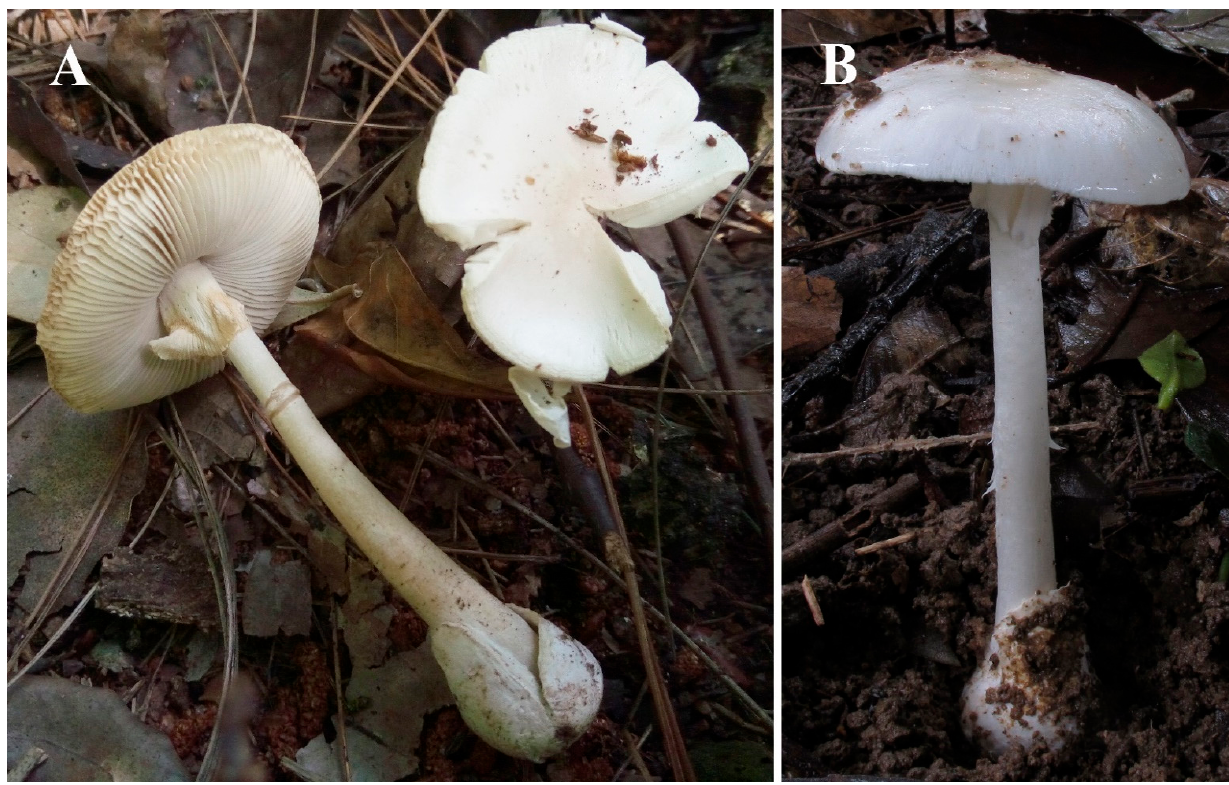
Figure 1. Deadly Amanita species for genome sequencing and peptide analyses. ( A ) Amanita rimosa . ( B ) Amanita exitialis .